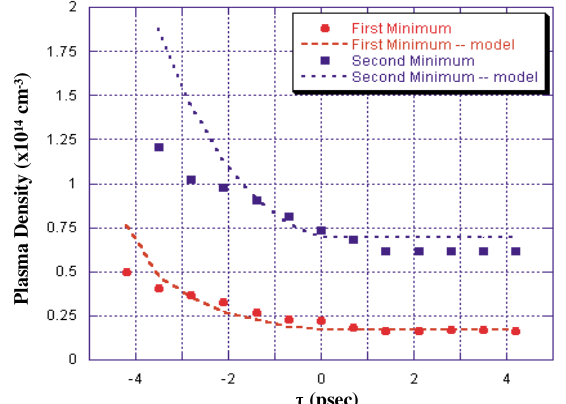
FIG. 9. (Color) The density location of the first two minima of each slice of Fig. 8 versus the temporal position of the slice. The red circles represent the movement of the first minimum in time (the red dashed line indicates the model’s predictions for the first minimum), and the blue squares represent the second minimum (the blue dotted line indicates the model’s predic- tions for the second minimum).